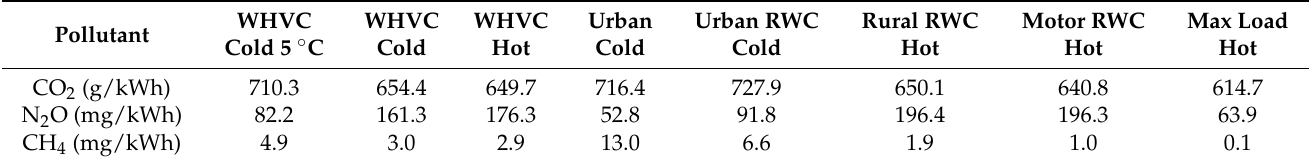
Table 1. Emissions of greenhouse gases for the various cycles (measured at the tailpipe with an FTIR). All tests at around 23 °C, unless otherwise specified. Rural